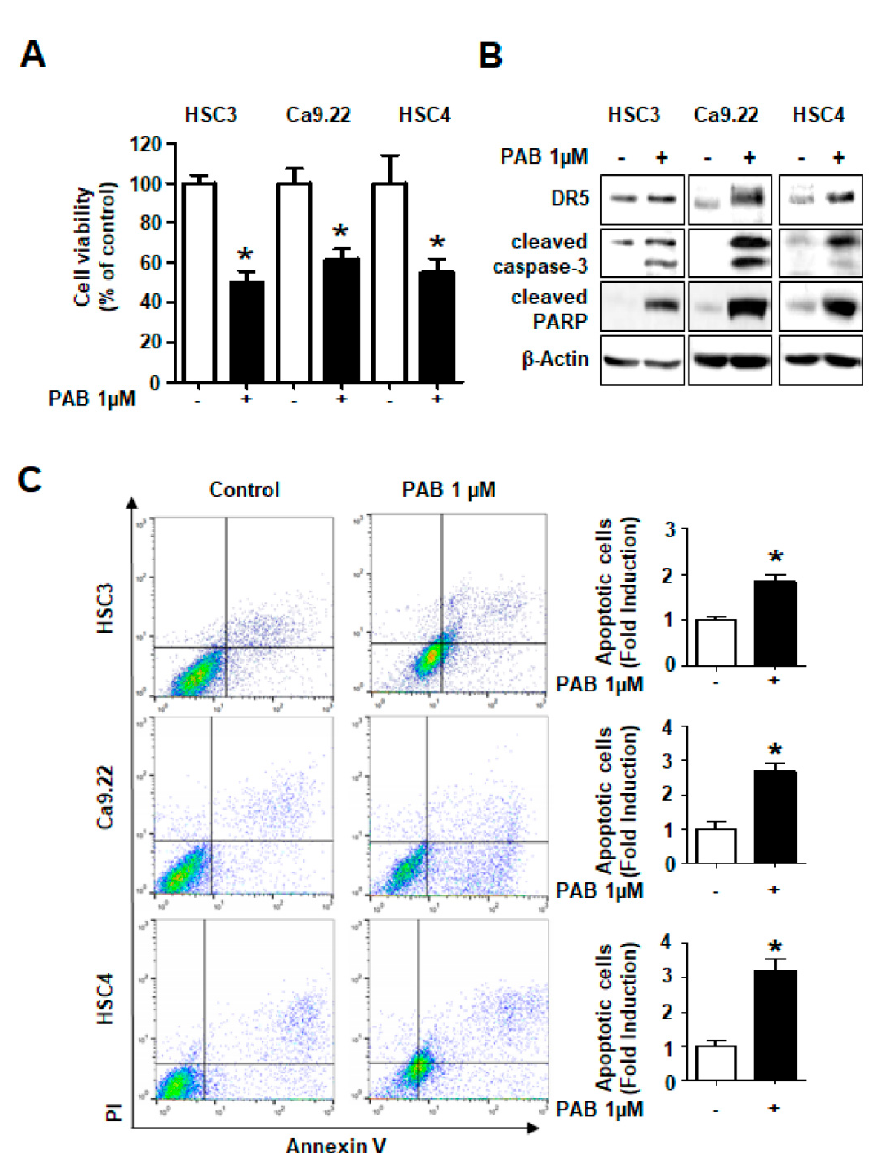
Figure 4. Growth-inhibitory and apoptotic effects of PAB in HSC3, Ca9.22, and HSC4 cells. ( A ) HSC3, Ca9.22, and HSC4 cells were treated with DMSO or PAB for 24 h, respectively. Effect of PAB on cell viability was examined by trypan blue exclusion assay. ( B ) Protein levels of DR5, cleaved caspase-3, and cleaved PARP were analyzed by western blotting. ( C ) Fluorescence-activated cell sorting (FACS) analysis of annexin V / propidium iodide (PI) staining. The graphs depict the mean ± SD of triplicates. (* p < 0.05).